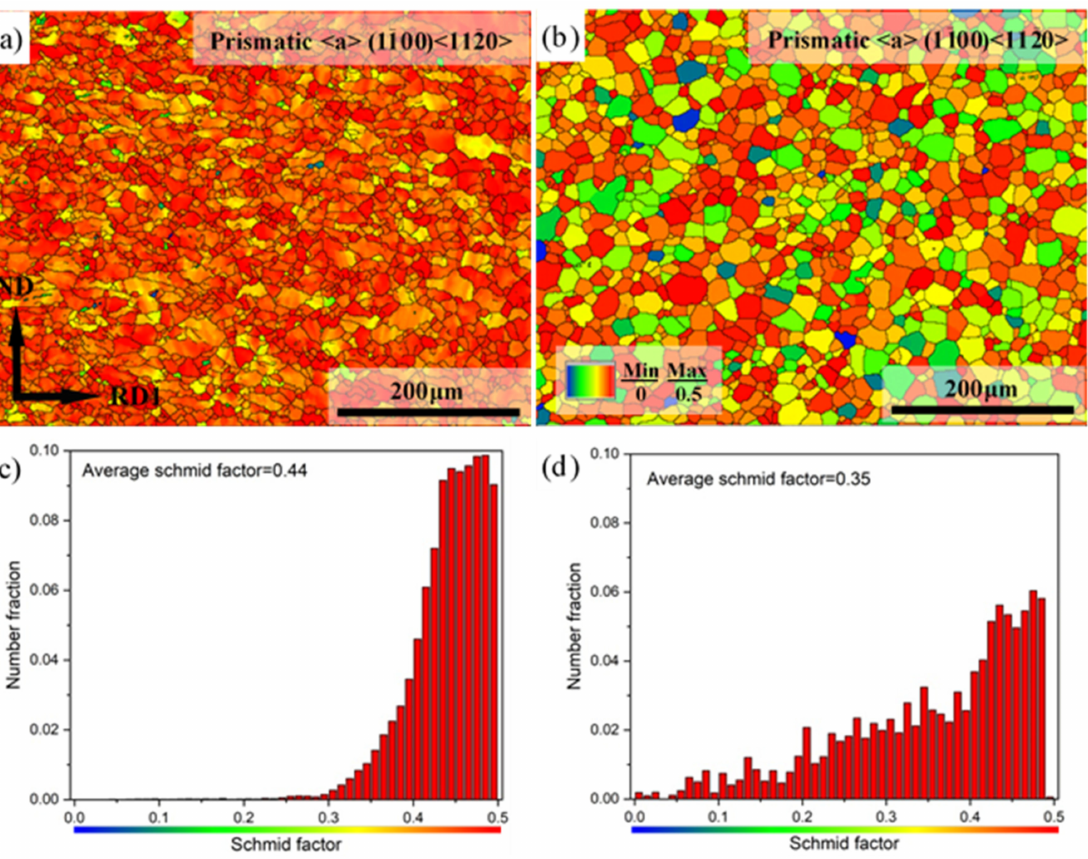
Figure 18. Prismatic <a> slip SF maps of ( a ) as-rolled, ( b ) as-annealed, and corresponding SF distributions of ( c ) as-rolled and ( d ) as-annealed Mg-3Y